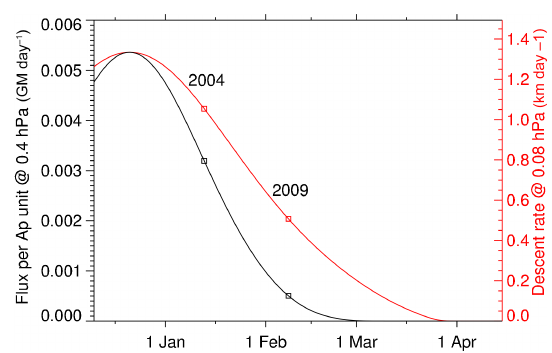
Figure 6. Dependence of the maximum EPP-NO y flux F ES m through the 0.4hPa level (black) and the descent velocity ω ES m at 0.08hPa (red) on the ES event